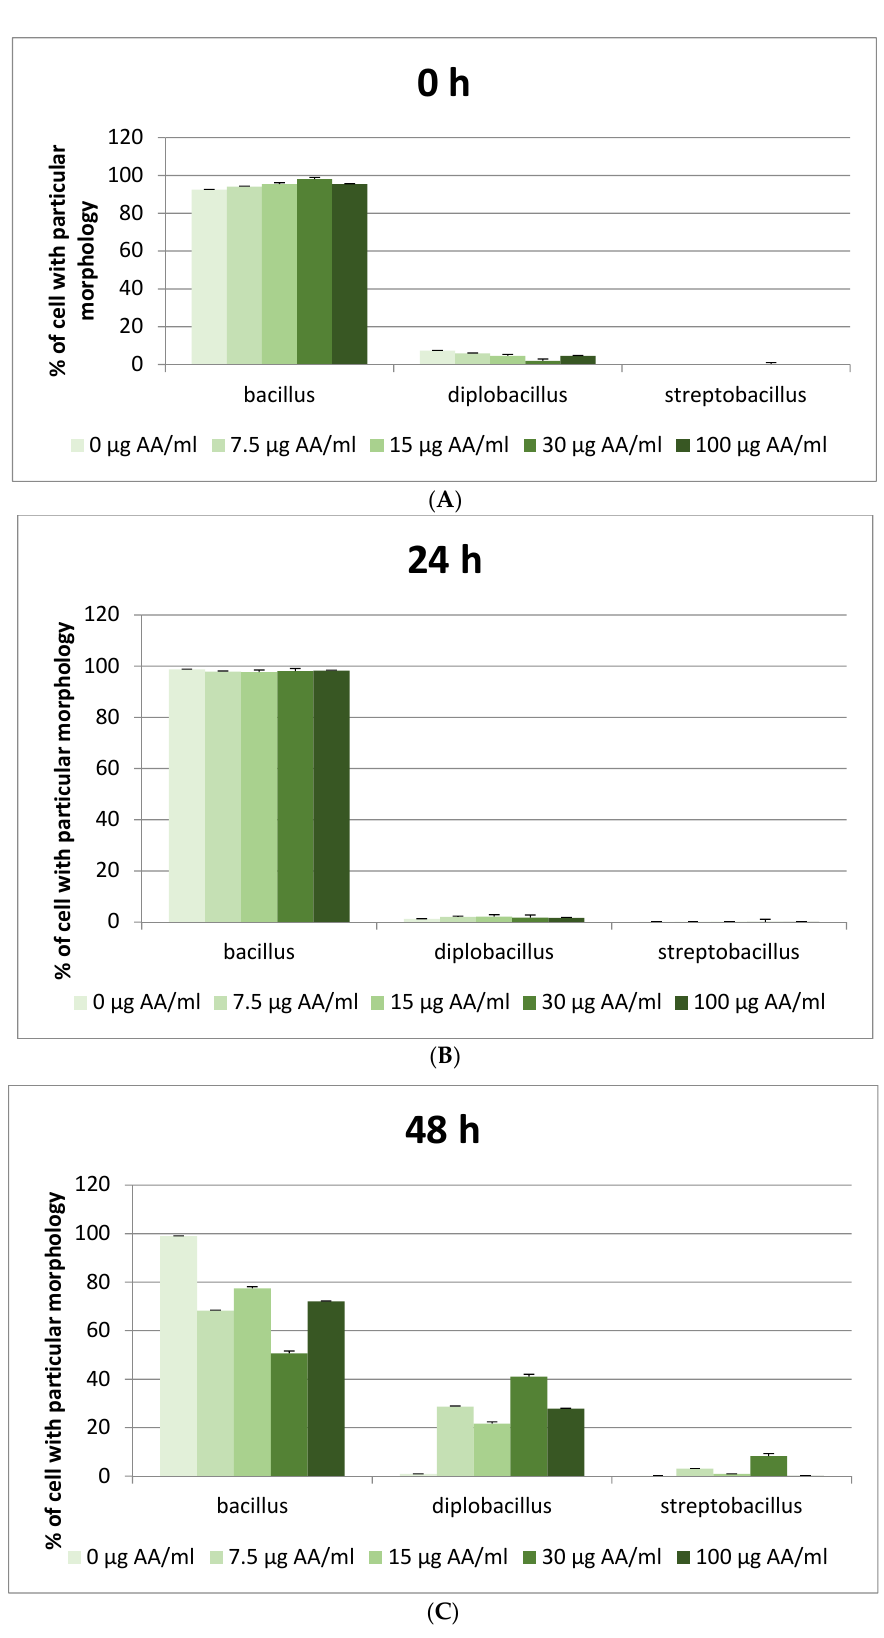
Figure 2. Impact of acrylamide concentration on the morphology of Lactobacillus plantarum . Then, it was tested whether the acrylamide concentration, regardless of the time of incubation, had a significant effect on the percentage of specific cell types (alive, injured, dead) or L. plantarum morphology (main effect of acrylamide concentration). The ANOVA results are presented in Table 3 and posthoc tests in Table 4. Table 3. The main effect of acrylamide concentration: influence of acrylamide concentration on the percentage of occurrence of certain cell types (expressed as arithmetic mean (SD)), regardless of the incubation time. Bacteria Strain